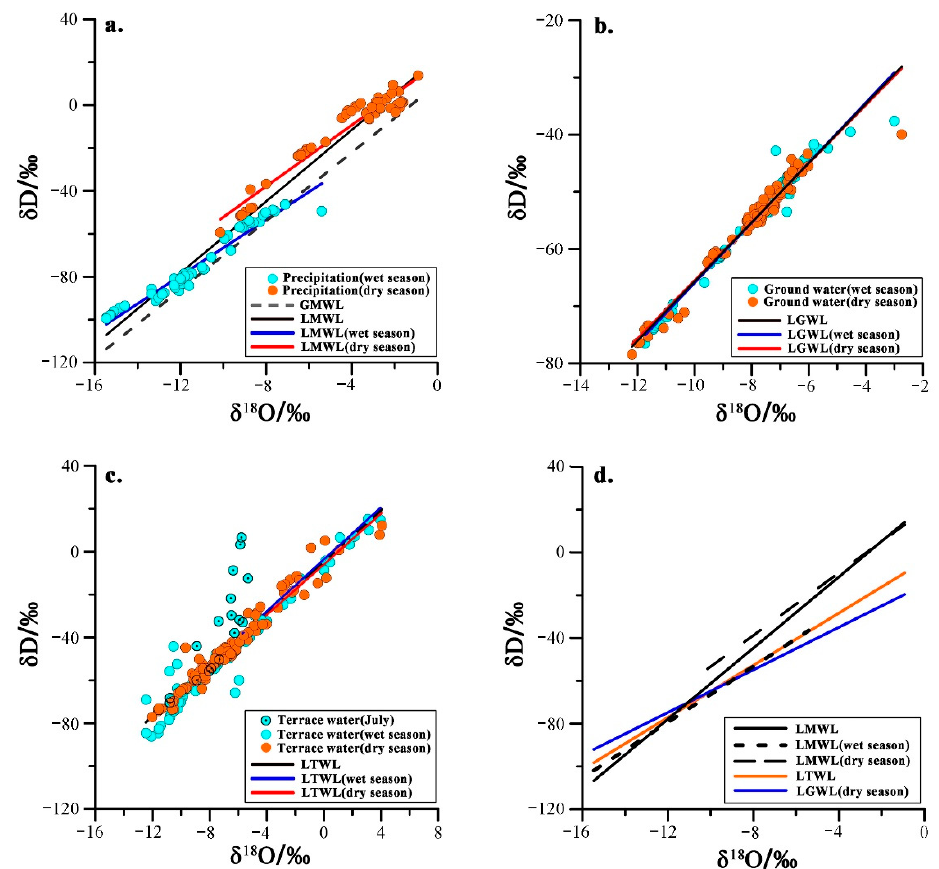
Figure 5. ( a ) Global Meteoric Water Line (GMWL) and Local Meteoric Water Line (LMWL) for the study area based on the data of individual sampling events from May 2015 to April 2016. ( b ) Local Ground Water Line (LGWL) for the study area based on the data of individual sampling events from May 2015 to April 2016. ( c ) Local Terrace Water Line (LTWL) for the study area based on the data of individual sampling events from May 2015 to April 2016. ( d ) The relationships between the δ D- δ 18 O relationships in precipitation, ground water, and terrace water.